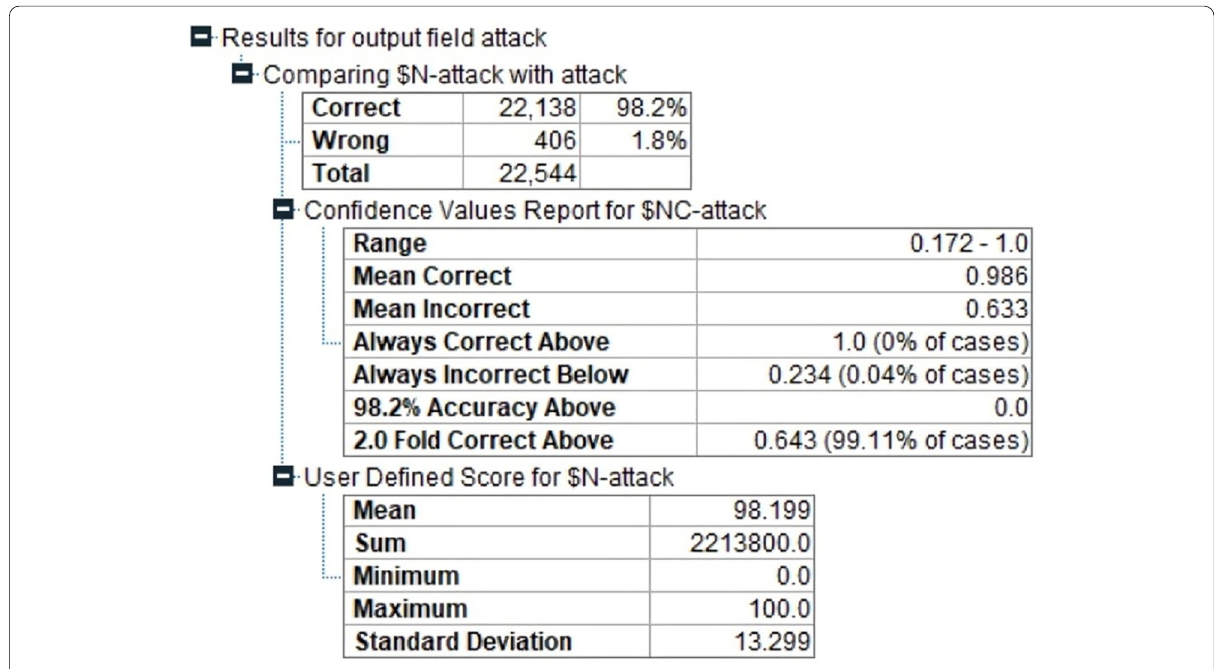
Fig. 16 accuracy level in Neural Network model